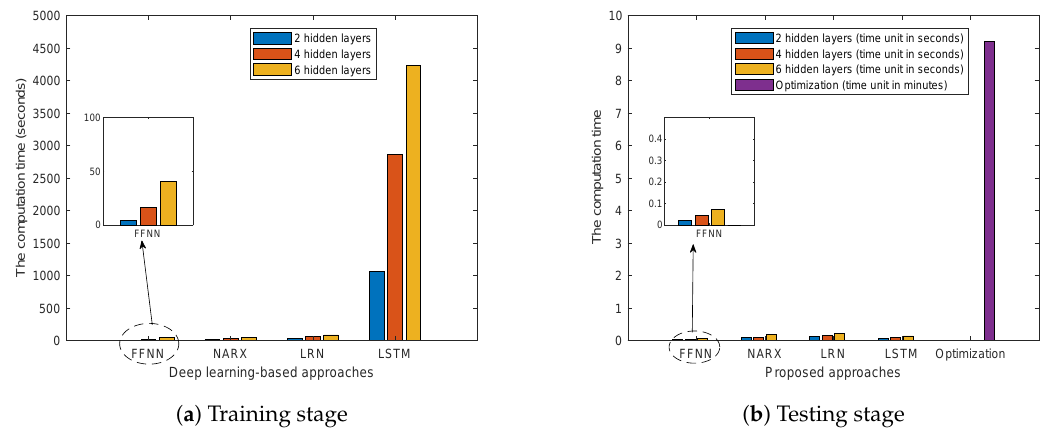
Figure 6. The computation time of training stage and testing stage when the number of hidden layers is 2, 4, and 6 layers respectively: ( a ) Computation time among FFNN, NARX, LRN and LSTM in the training stage. ( b ) Computation time among FFNN, NARX, LRN, and LSTM and optimization scheme in the testing